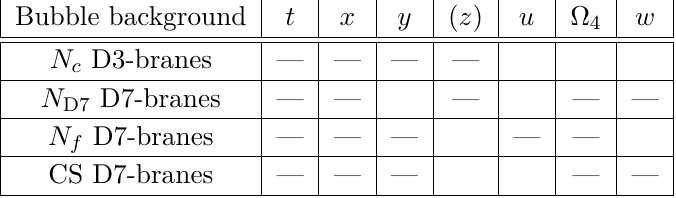
Table 3 . The D-brane configuration including various